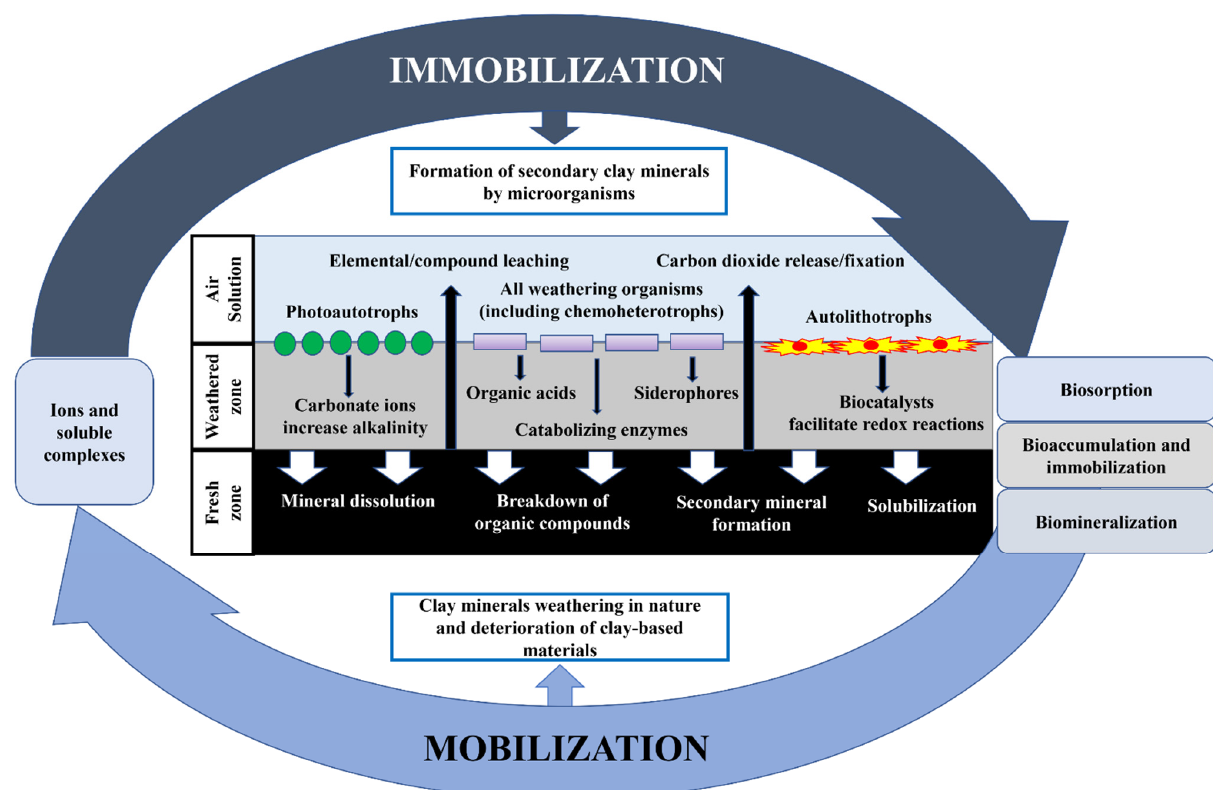
Figure 4. Diagram of biogeochemical processes involved in the transformation of clay minerals and weathering mechanisms on geological substrates. Images adapted from [97,98].